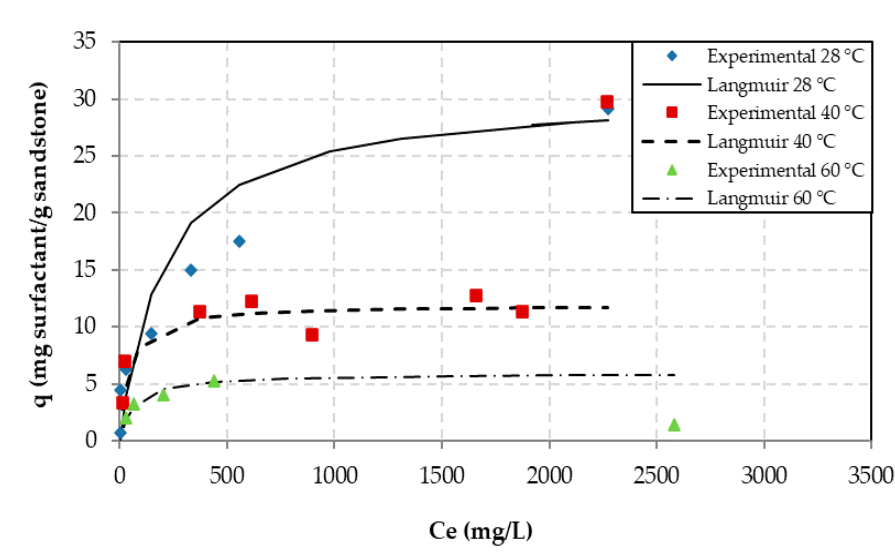
Figure 4. SCO/glycerol free adsorption isotherm.